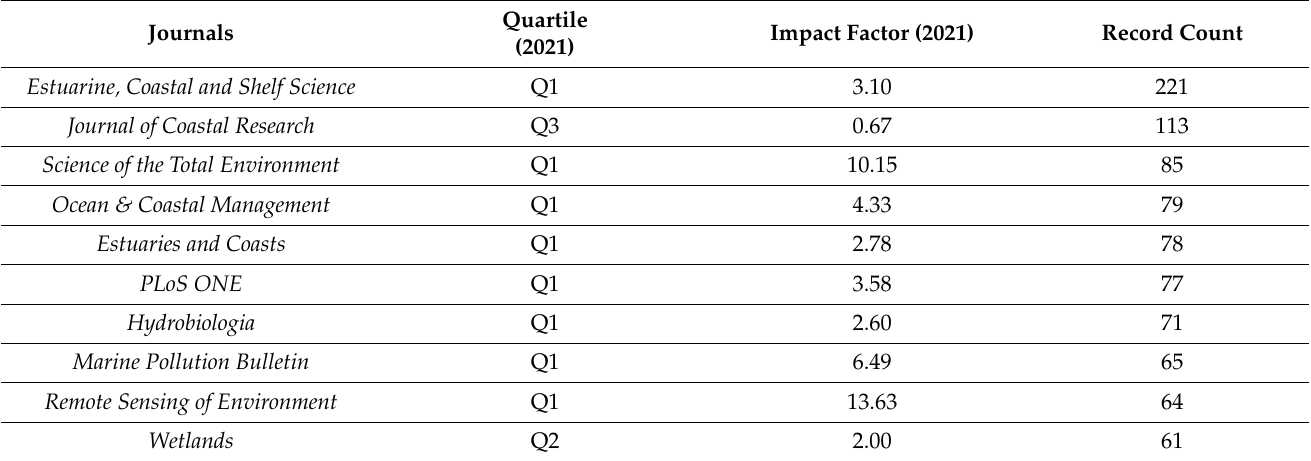
Figure 2. The number of original research articles on the impact of climate change on mangrove forest-related studies published between 1977 and 2021. Table 1. Top 10-most productive journals publishing papers on the impact of climate change on mangroves.